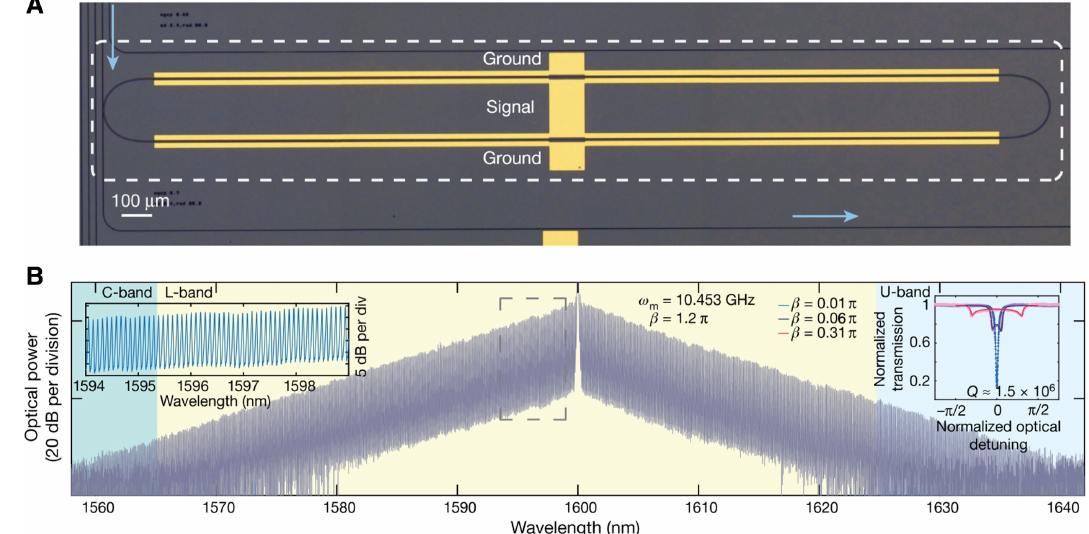
Figure 23: Broadband electro-optic frequency comb generation in a lithium niobate microring resonator. (A) SEM diagram of a lithium niobate microring resonator. (B) Ultra broadband frequency comb spectrum. Reprinted by permission from Zhang et al. [84], Springer Nature Limited, copyright